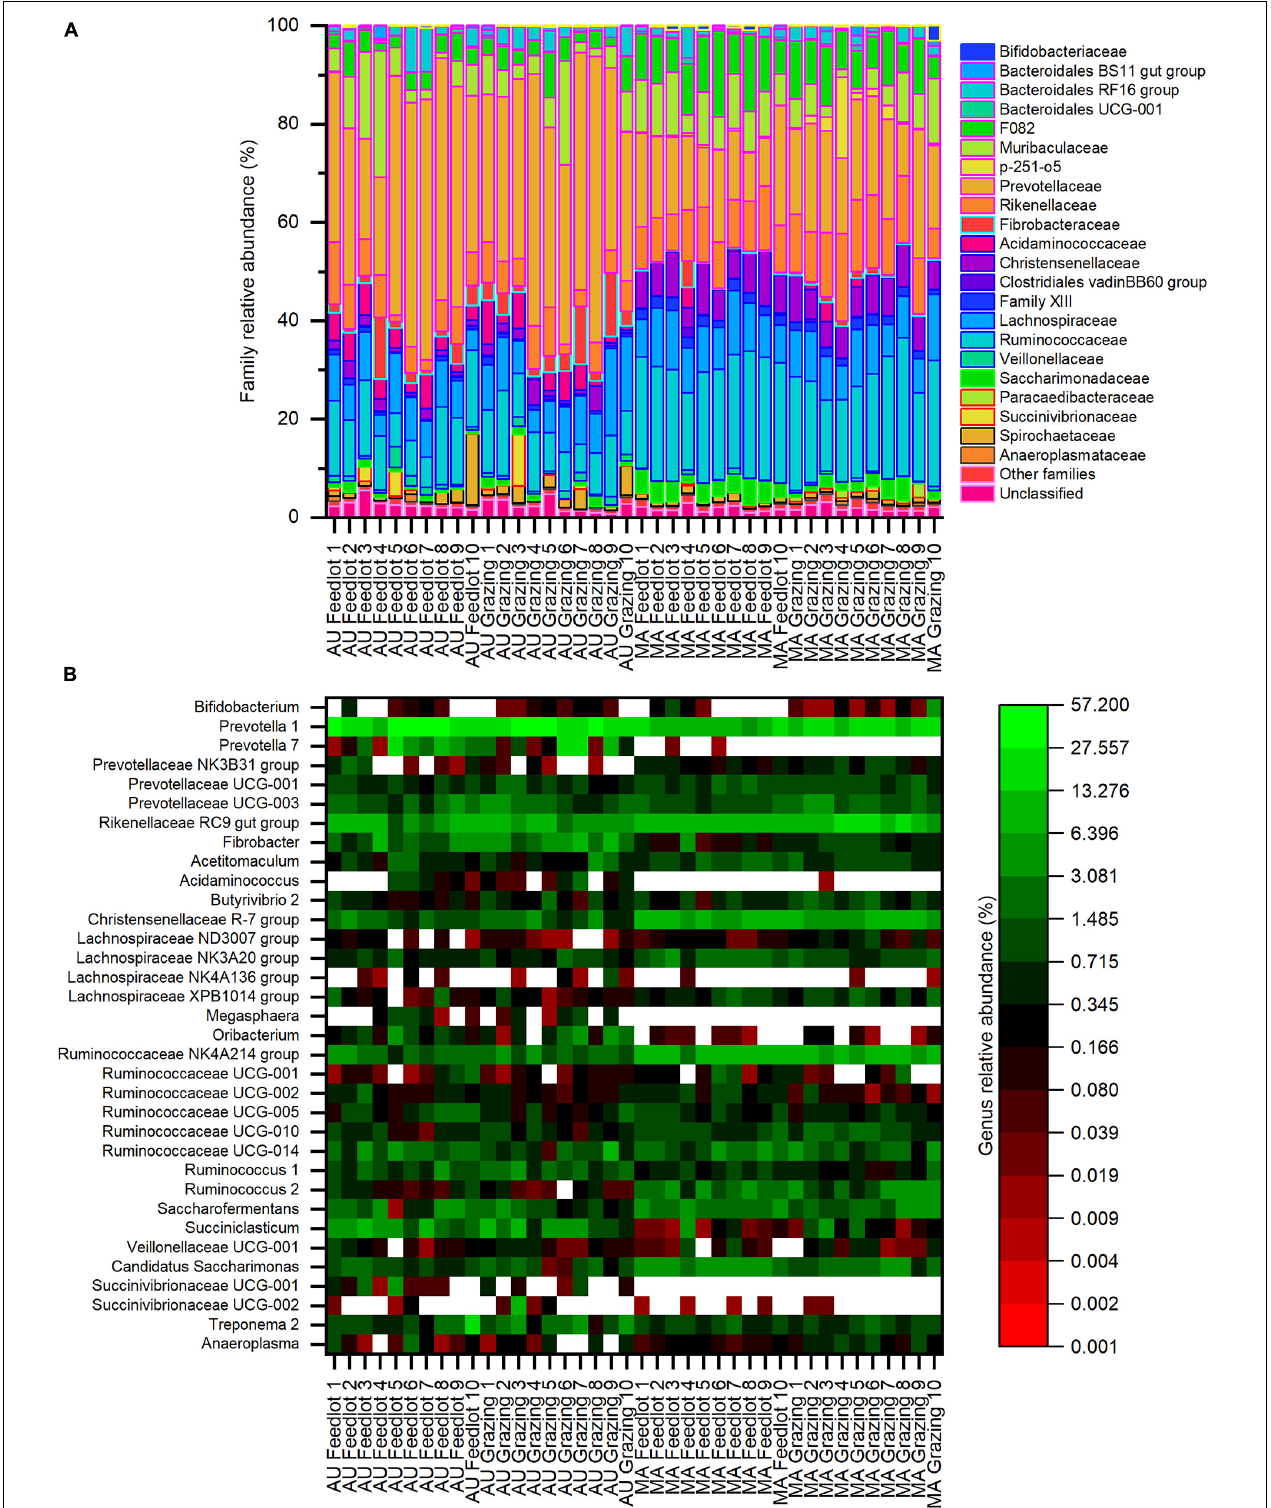
FIGURE 3 | Composition of bacterial communities at the (A) family and (B) genus levels for the Aubrac (AU) and Maremmana (MA) breeds in the two rearing systems (feedlot and grazing). Only the genera with a relative abundance of at least 1% in at least one sample are reported. Within the whole dataset, the most relatively abundant families were Prevotellaceae, Ruminococcaceae, and Lachnospiraceae, whereas the most relatively abundant genus was Prevotella .